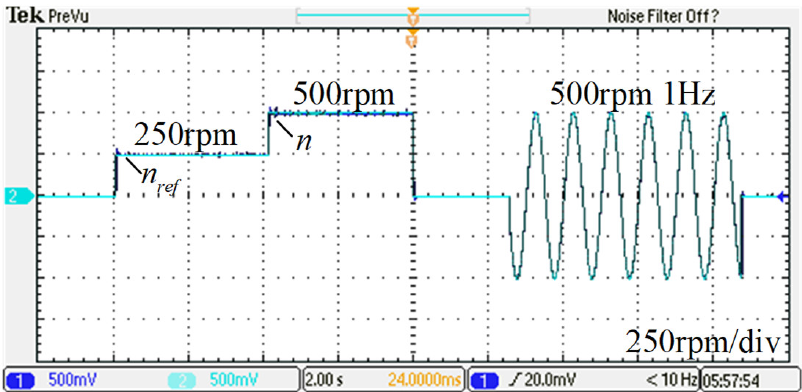
Figure 5. Continuous speed transient state: Channel 1: actual speed, Channel 2: reference speed (250 rpm/div), Horizontal: Time (2 s/div).